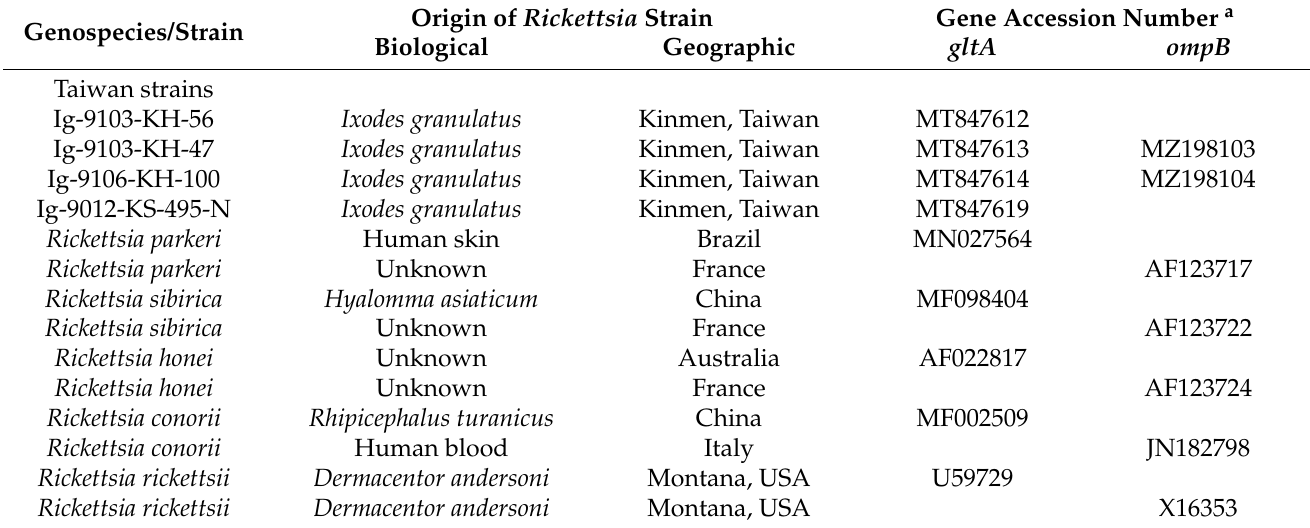
Table 1. Phylogenetic analysis based on gltA and ompB genes of Rickettsia used in this study.